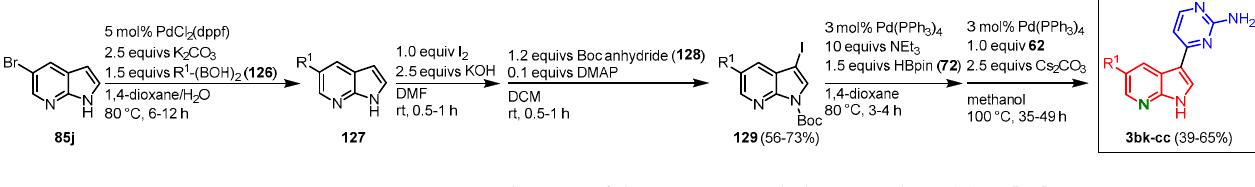
Figure 35. Functionalization of the C-5 position led to meriolins 3bk - cc [73]. Table 2. Boronic acids 126 used for the functionalization in C-5 position and the corresponding yields of meriolins 3bk - cc.